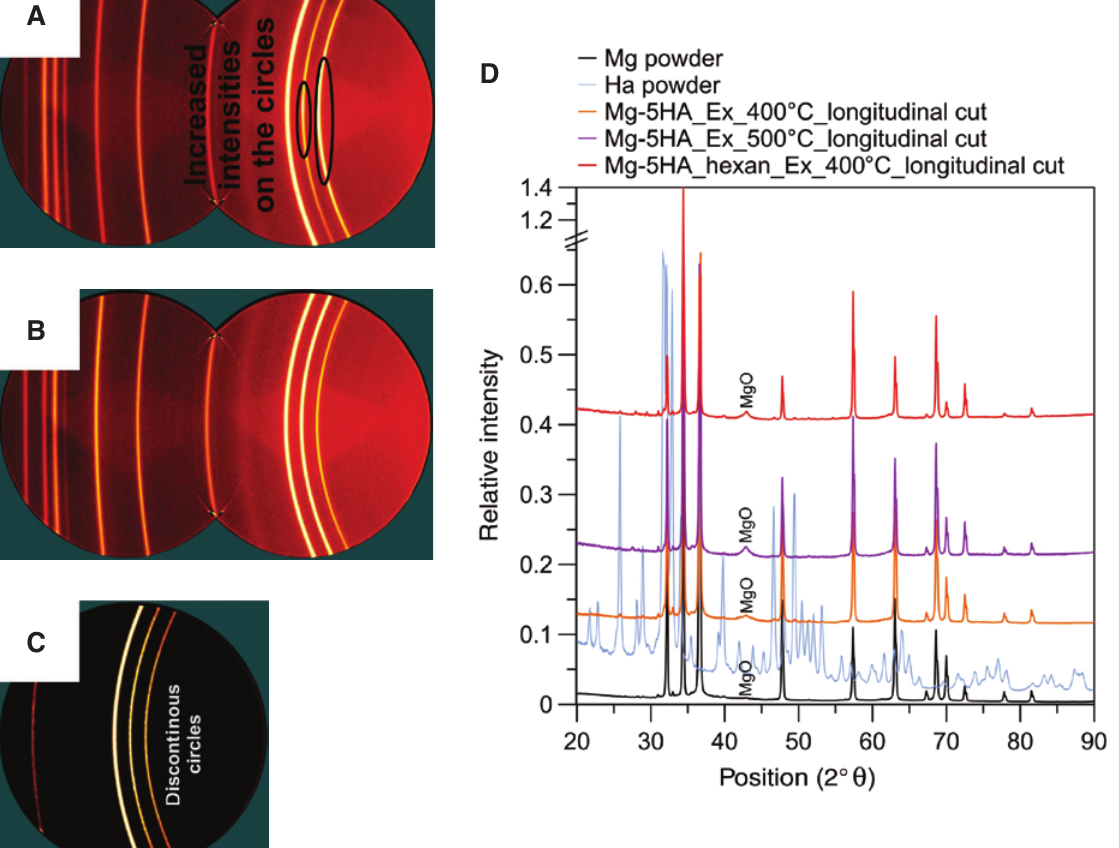
Figure 4: XRD measurements: (A) Diffraction lines for Mg phase in Mg-5HA composite in cross-section, (B) diffraction lines for Mg phase in Mg-5HA composite in longitudinal section, (C) diffraction lines for Mg powder, and (D) XRD plots of studied